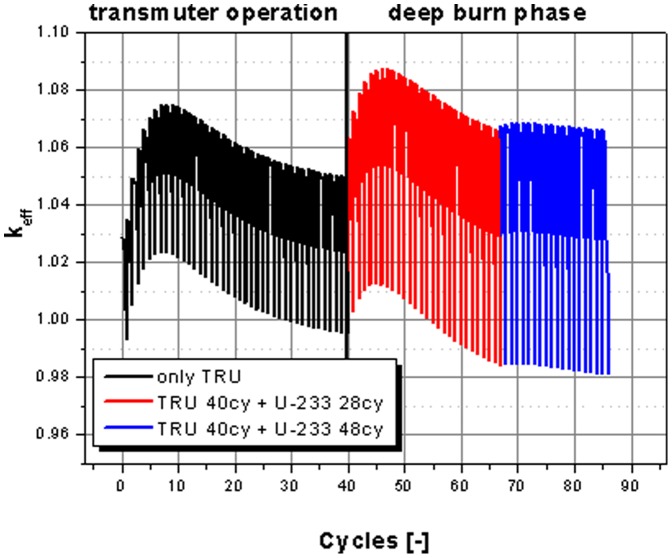
keff evolution over burnup for the 40 operational cycles (transmuter operation) and the extended operation with U-233 feed (deep burn phase).